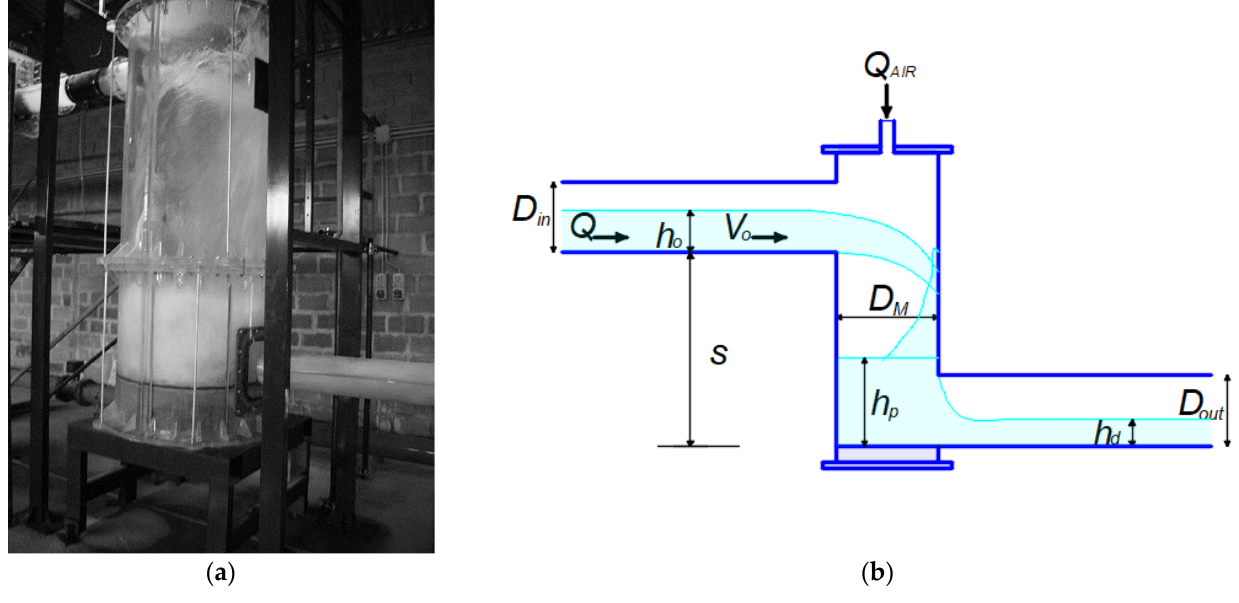
Figure 1. The experimental model: ( a ) image of Model 1, with clearly visible air entrainment phenomena; ( b ) sketch of the model with indicated symbols.